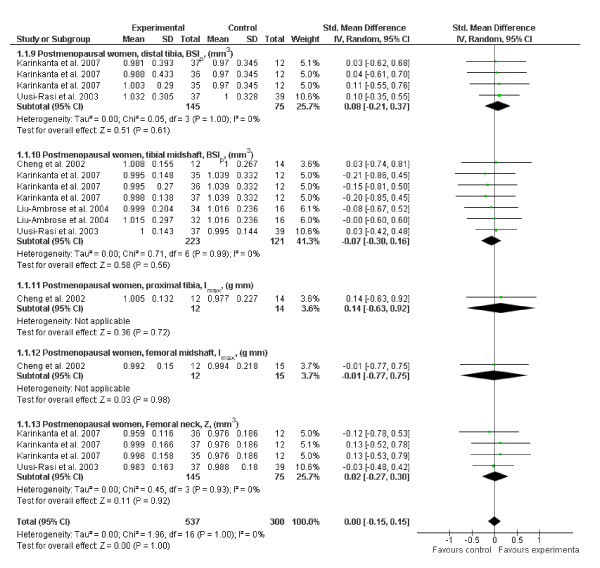
Effects of exercise on bone strength (standard mean difference, 95% CI) in postmenopausal women at the distal tibia, mid tibia, femoral neck, midfemur and proximal tibia. The squares and diamonds represent the test values for individual studies and the overall effect, respectively.